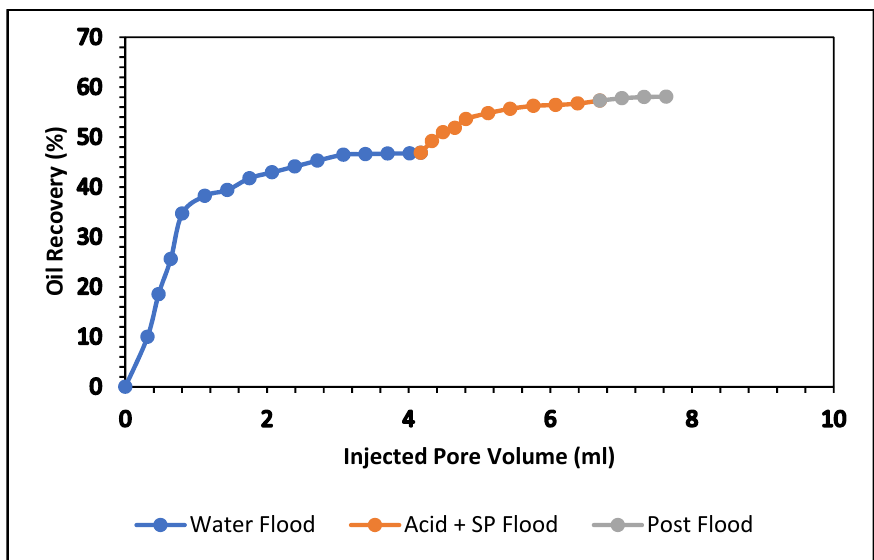
Figure 15. Total oil production from the carbonate core after brine, 0.5% Acrylic acid, and SP mixture, followed by a post-flood with brine.